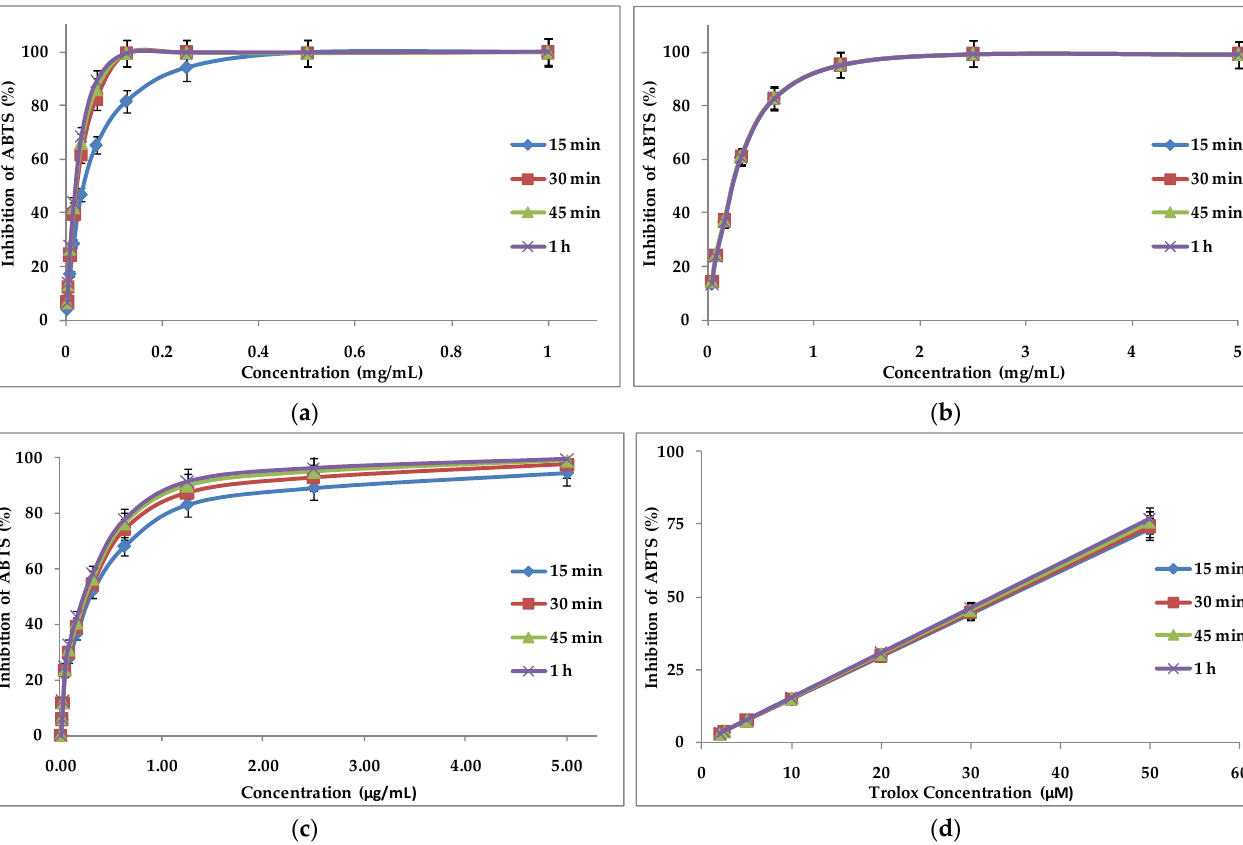
Figure 5. ABTS scavenging activity of ( a ) MeOH extract; ( b ) EtOH extract; ( c ) EO, from A. foeniculum AdB; and ( d ) Trolox. Each value is the mean of three replicates ± SD. Table 4. IC 50 values for antioxidant assays.